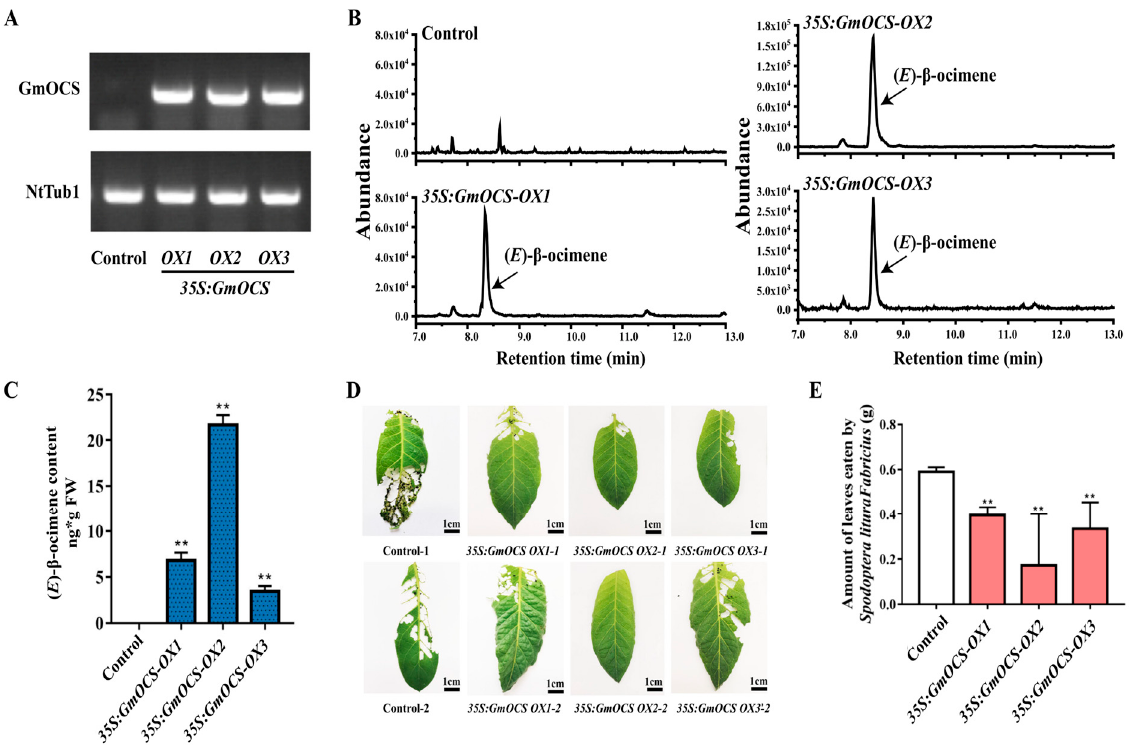
Figure 6. The overexpression of GmOCS in N. tabacum led to enhanced resistance against S. litura . ( A ) Expression analysis of the GmOCS gene by RT-PCR in the wild type and transgenic tobaccos. ( B ) The terpene release pattern detected from the control and transgenic tobacco leaves overex- pressing GmOCS . ( C ) Relative contents of volatile terpenes detected in the control and transgenic soybean leaves overexpressing GmOCS . ( D ) S. litura attacked wild leaves and transgenic leaves, overexpressing GmOCS in a dual-choice feeding-preference experiment. ( E ) Leaves of wild and GmOCS overexpressed lines eaten by S. litura in a dual-choice feeding-preference experiment. Data represented the mean ± SD of three biological replicates, and the student’s t -test was used to analyze the signi fi cance of di ff erences (** p < 0.01) in ( B , E ).